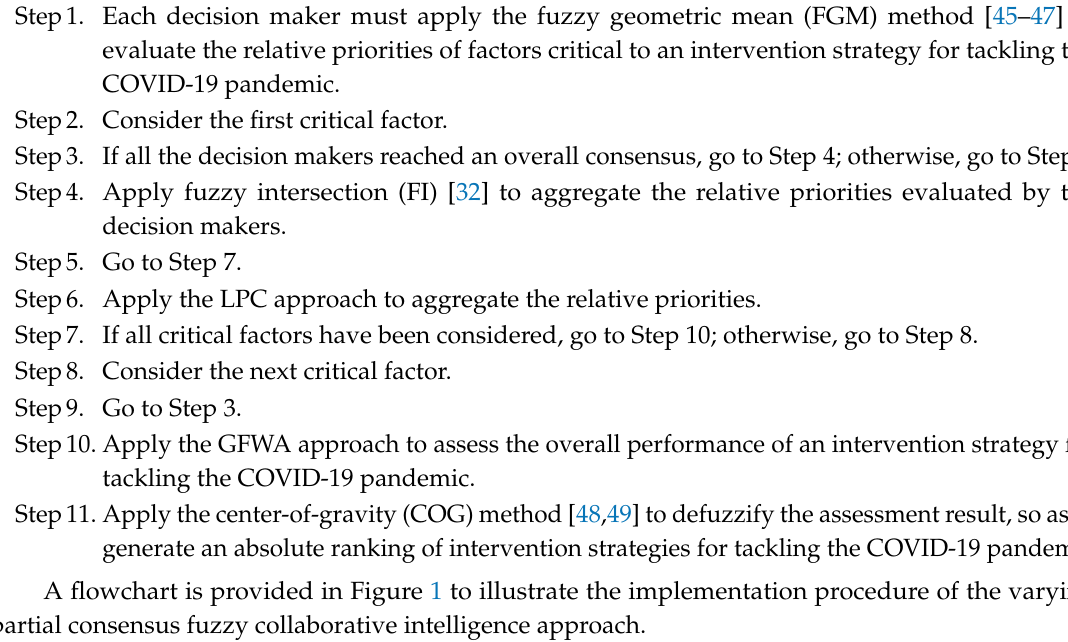
Figure 2. Problem structure. 3.2. FGM Method for Evaluating the Relative Priorities of Critical Factors In the proposed methodology, first each decision maker evaluates and compares the relative priorities of critical factors in pairs using the FGM method. The comparison results are expressed in linguistic terms such as “as equal as,” “weakly more important than,” “strongly more important than,” “very strongly more important than,” “absolutely more important than,” etc. A prevalent way is to associate these linguistic terms with triangular fuzzy numbers, as summarized Table 2 [46]. Usually, these triangular fuzzy numbers (TFNs) are within [1,9]. By widening these TFNs, the possibility for decision makers to reach a consensus increases [20]. In addition, restricting these TFNs